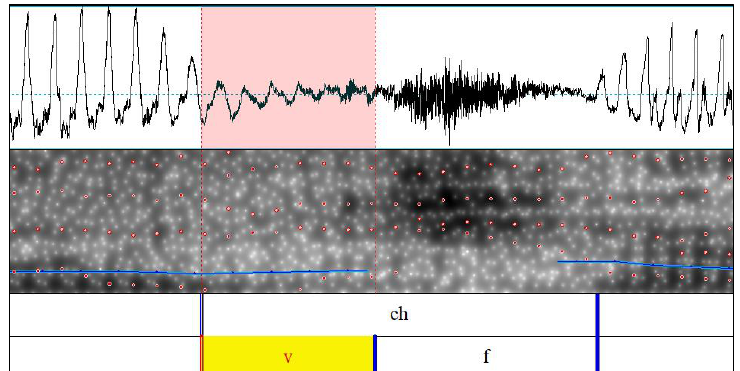
Figure 3. Coding of [ ʧ ] in the word mucha “ a lot ” . The affricate has a stop section with no clear release. Male speaker (UT086).